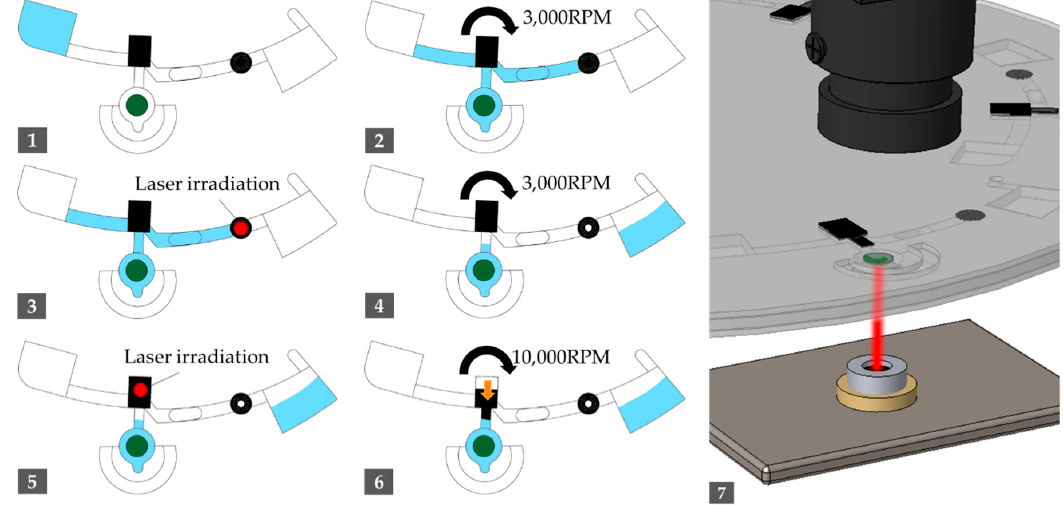
Figure 3. Disc driving sequence indicating the current flow of the fluid (sky-blue). The number index indicates each step 1-7 of Table 1.